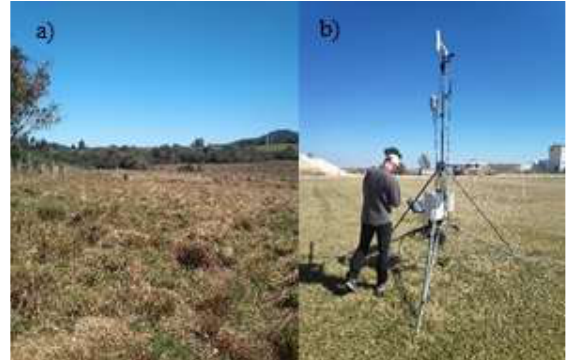
Figure 2. a) Santa Maria experimental site with native grassland; b) Barrax experimental site with cultivated